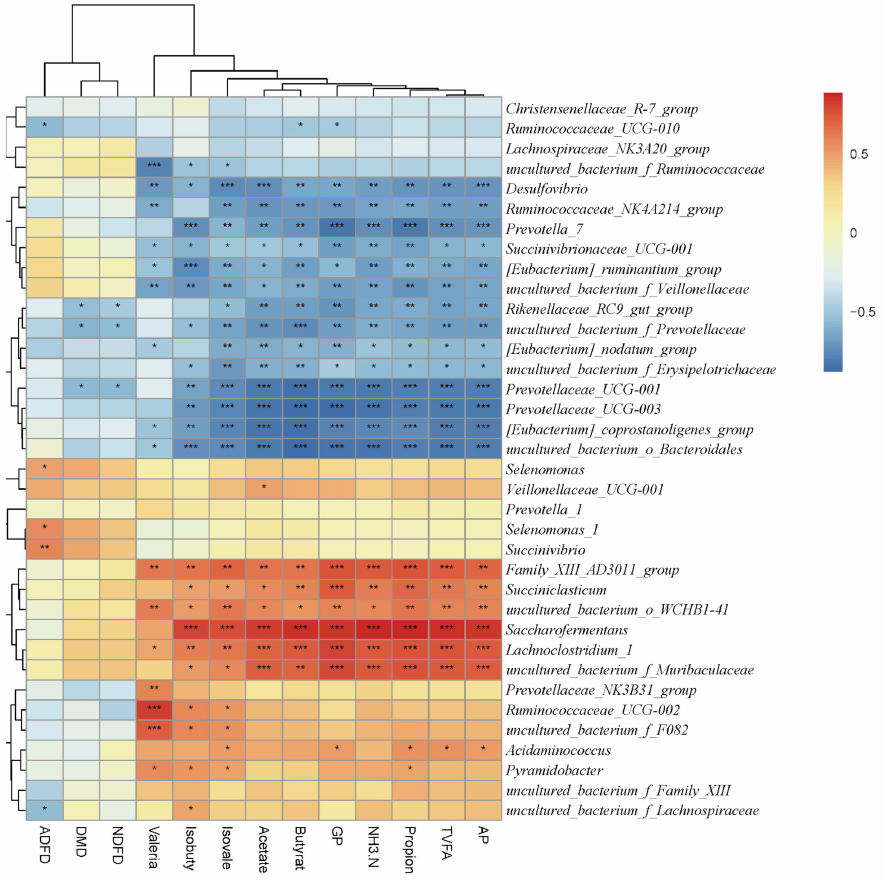
Figure 5. Correlation heat map. Note: ADFD, acid detergent fiber digestibility; DMD, dry matter digestibility; NDFD, neutral detergent fiber digestibility; GP, gas production; TVFA, total volatile fatty acids; AP, the ratio of acetic acid to propionic acid; * p < 0.05, ** p < 0.01, *** p <